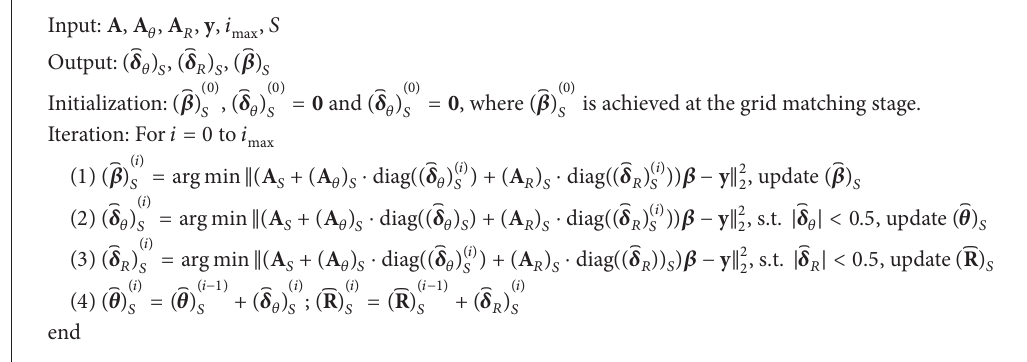
Algorithm 2: AIM